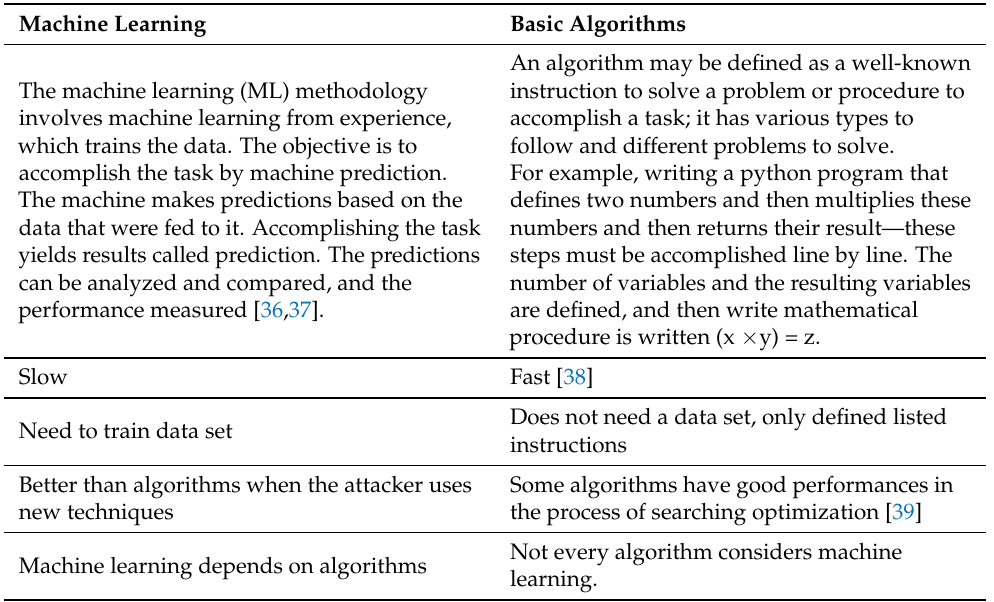
Table 4. Defacement-based machine-learning algorithms vs. basic algorithms. Machine Learning Basic